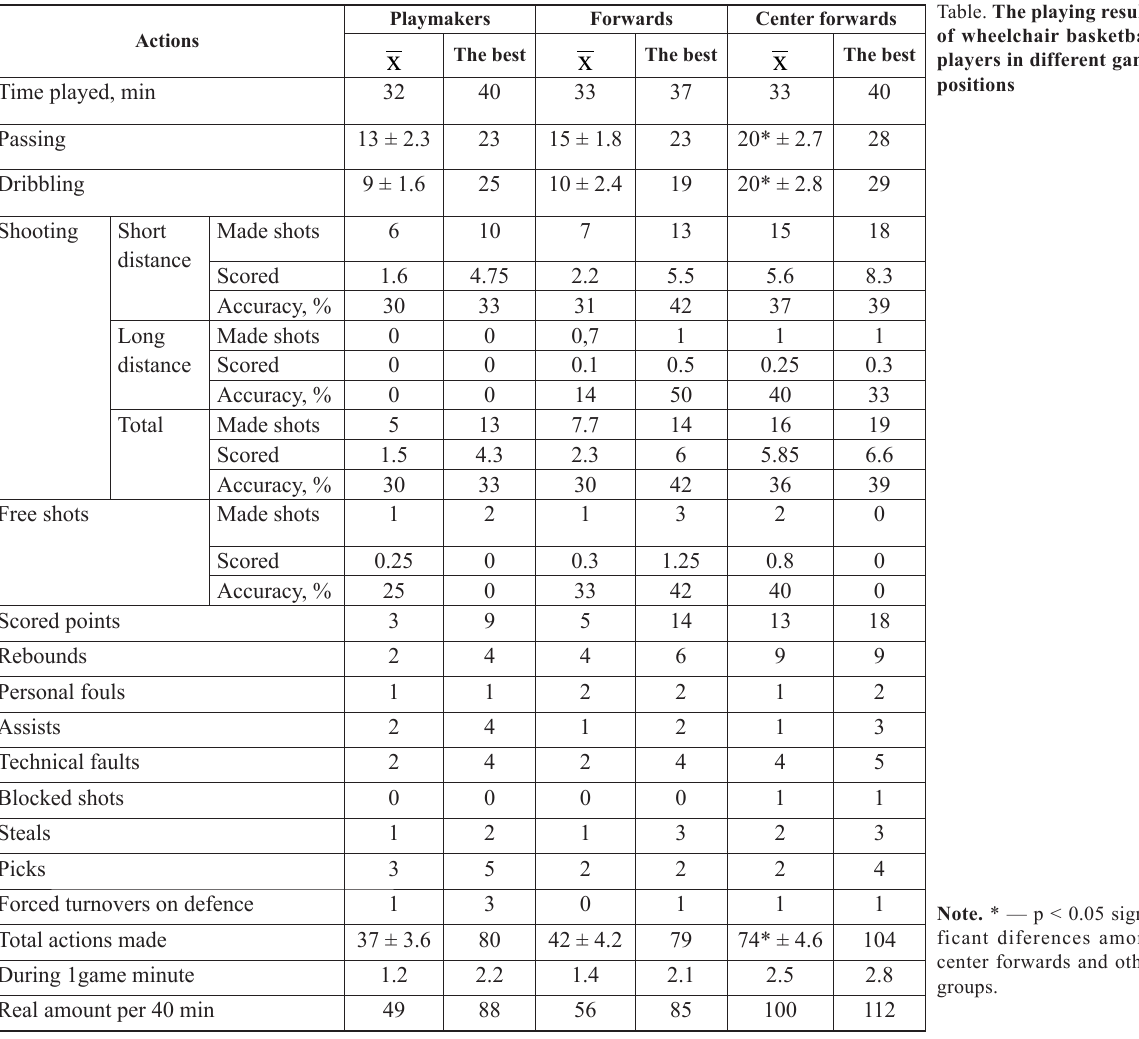
Table. The playing results of wheelchair basketball players in different game